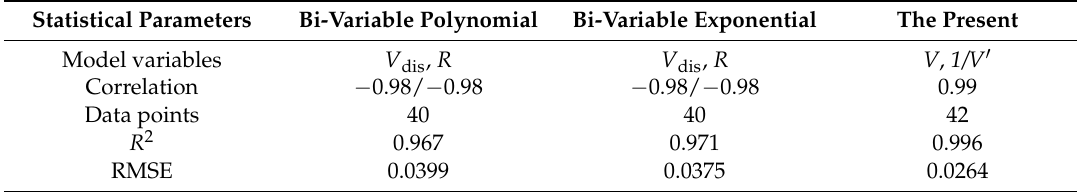
Table 8. Comparisons of the present SOH model with the bi-variable SOH model